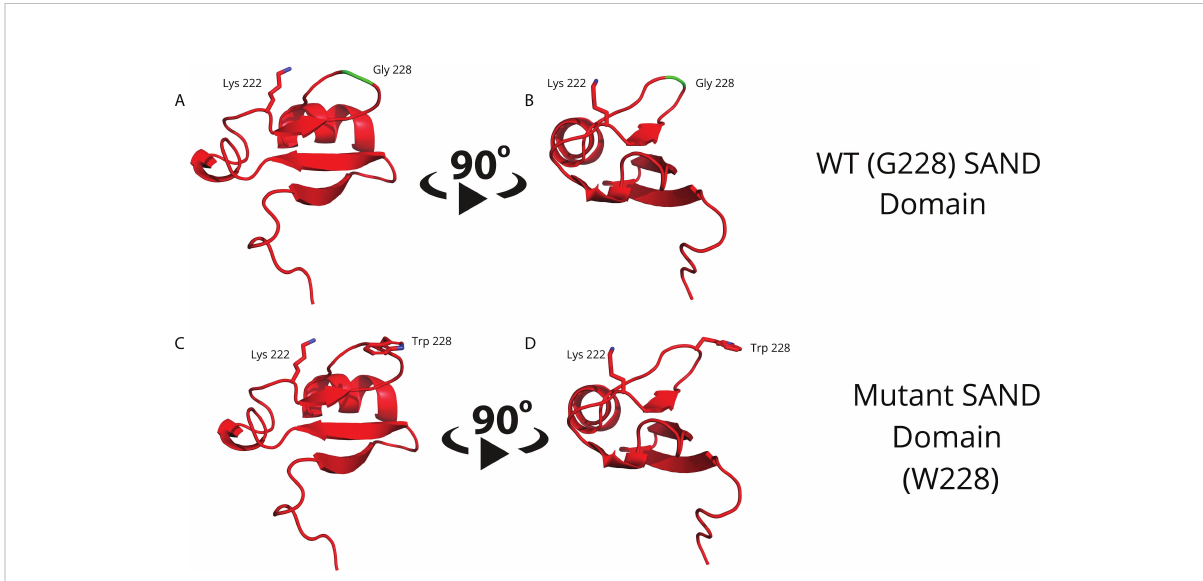
FIGURE 1 Molecular modeling of the G228 (Gly228) wild-type (A, B) or mutant W228 (Trp228) AIRE SAND domain (C, D) as acquired through homology modeling using the Swiss – Model with the human SP100 SAND domain as a template. The G228W mutation is located in a loop region and does not directly interfere with the formation of a secondary